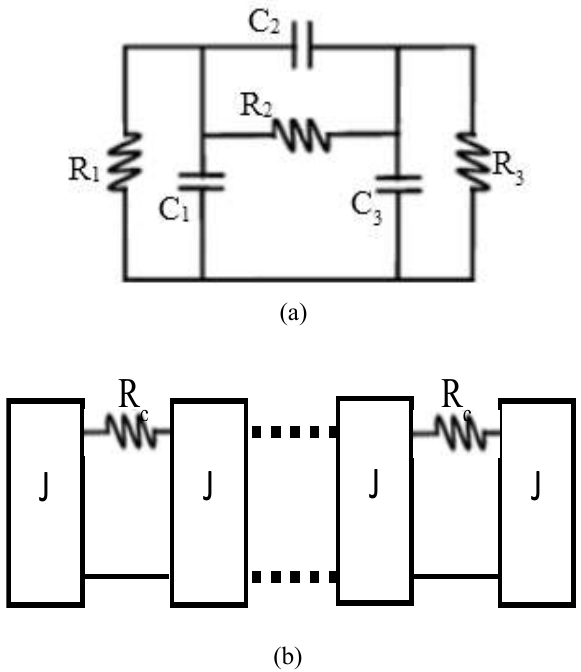
Figure 6. Equivalent circuits: (a) Single SIW cavity FSS J. (b) Cascading SIW cavity